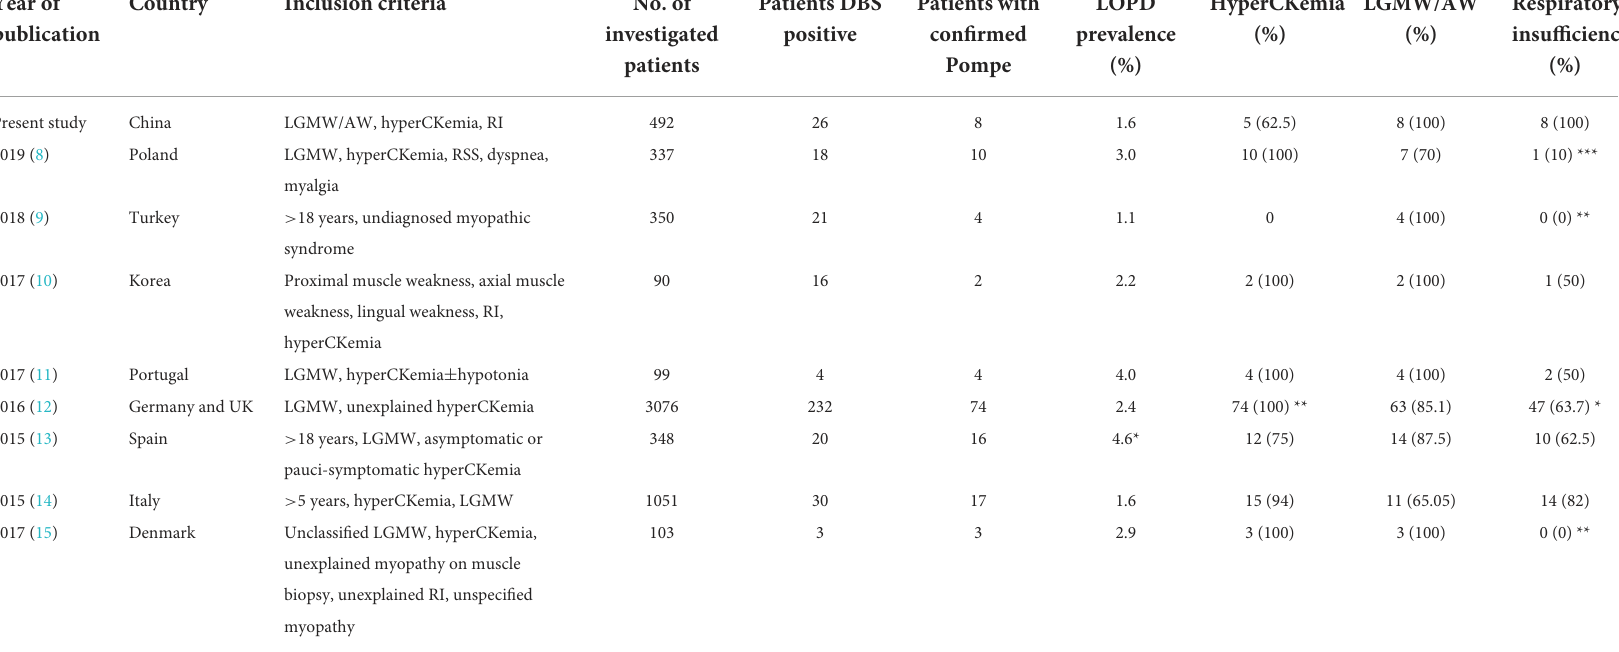
TABLE 3 High-risk screening studies in late-onset Pompe